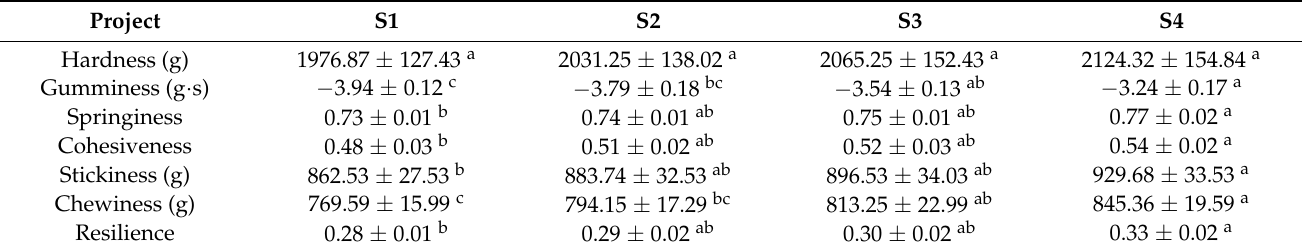
Table 3. Effects of different cooling rates on meat texture of crucian carp.